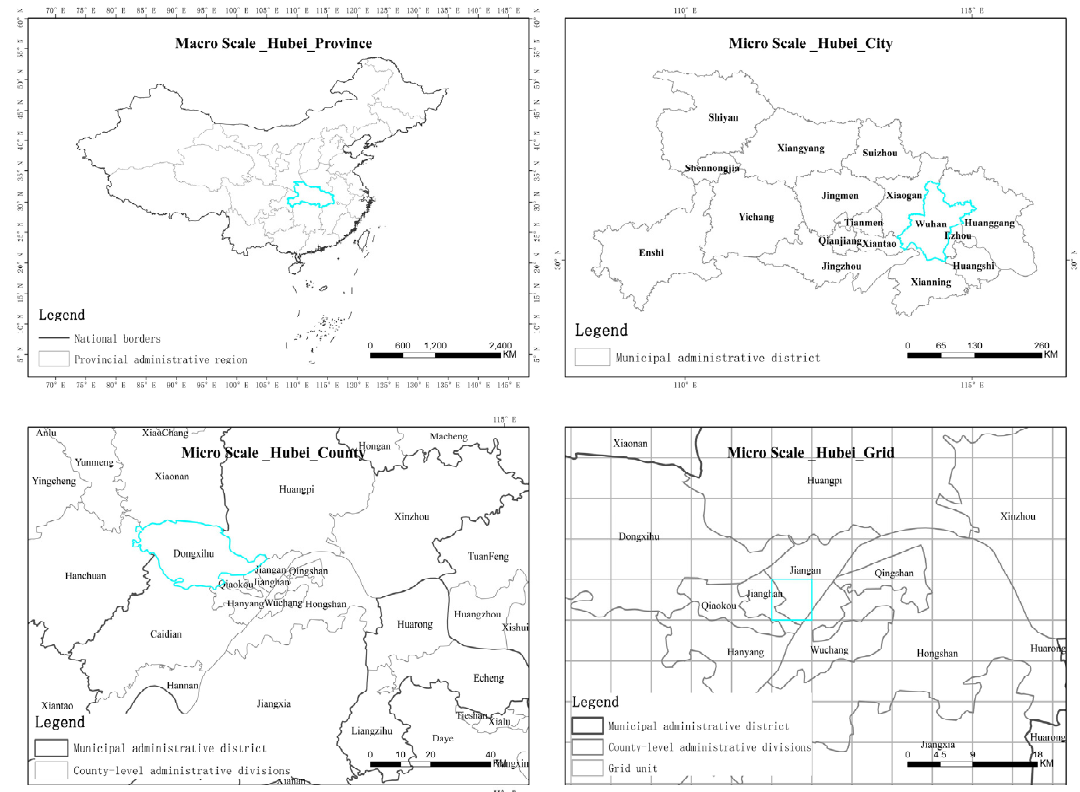
Figure 1. Survey map of the study